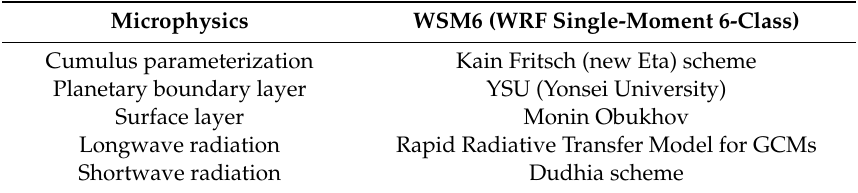
Table 3. Physical parameterization